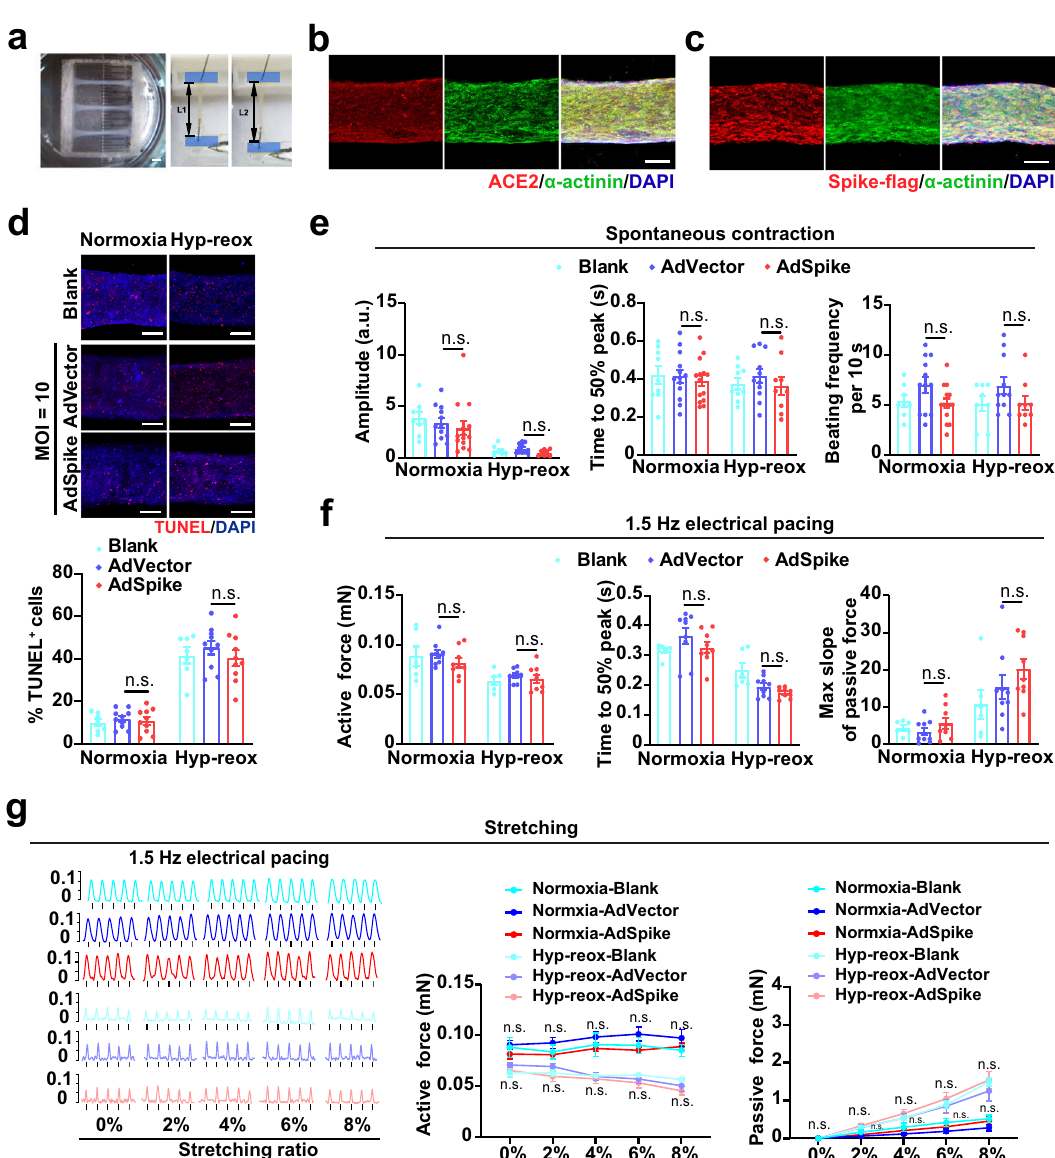
Fig. 4 AdSpike has little effect on hEHTs that underwent spontaneous contraction, electrical fi eld stimulation, and mechanical tensile test with or without hyp-reox injury. a Low magni fi cation image of hEHT on day 21 (left) and the equipment image of mechanical contractility force test for hEHT (right). Scale bar, 2 mm. b , c Co-localization analysis of anti- α -actinin (green) and anti-ACE2 (red) or anti-Spike- fl ag (red) with DAPI (blue). Scale bar, 200 μ m. d Representative image and quanti fi cation of TUNEL staining in hEHTs with or without hyp-reox injury. n = 7 – 10 for each group. Scale bar, 200 μ m. e Video analysis of the hEHTs for spontaneous contraction amplitude, time to 50% peak, and beating frequency per 10 seconds. a.u., absolute units. n = 9 – 14 for each group. f The active contractile force, time to 50% peak and maximum slope of passive force of the bundles at 1.5 Hz electrical pacing with or without hyp-reox injury. n = 6 – 9 for each group. g Representative contractile force traces and active contractile force during progressive stretching (0%, 2%, 4%, 6%, and 8% tissue length) of hEHTs with or without hyp-reox injury on day 22. n = 5 – 9 for each group. Statistical signi fi cance was assessed using 2-way ANOVA with Turkey post-test. Data are presented as mean ± SEM; n.s., not signi fi cant, compared with the corresponding AdVector control, in which the black color indicates comparison within the normoxia group, and gray color indicates comparison within the hyp-reox